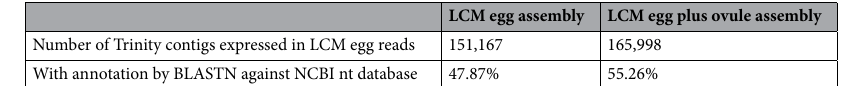
Number of Trinity contigs expressed in LCM egg